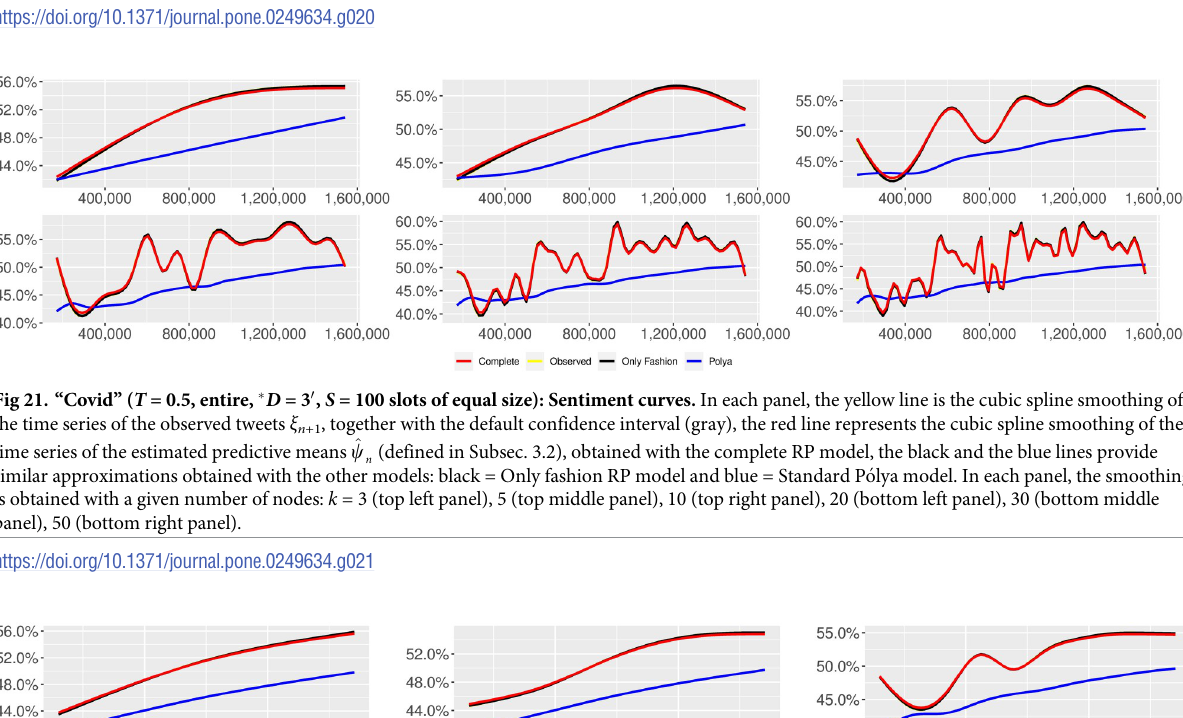
PLOS ONE | https://doi.org/10.1371/journal.pone.0249634 April 15, 2021 24 /